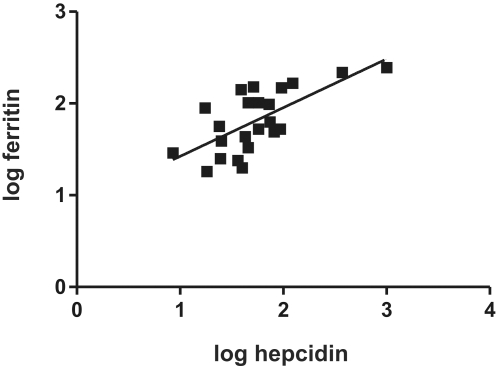
Correlation between serum hepcidin and ferritin.Serum hepcidin levels in 23 healthy volunteers (Table 2), as determined by our updated MS method, were correlated with their ferritin levels. Values were log transformed prior to correlation analysis. Pearson correlation: 0.6804 (p = 0.0004).